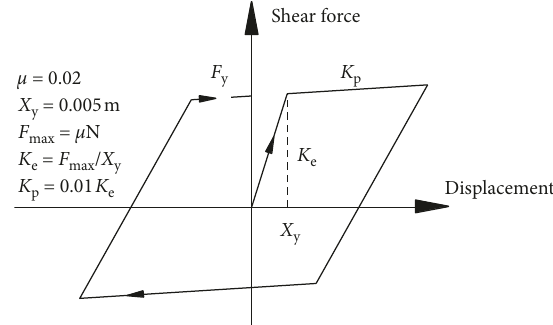
Figure 4: Mechanical model of the pot bearings.